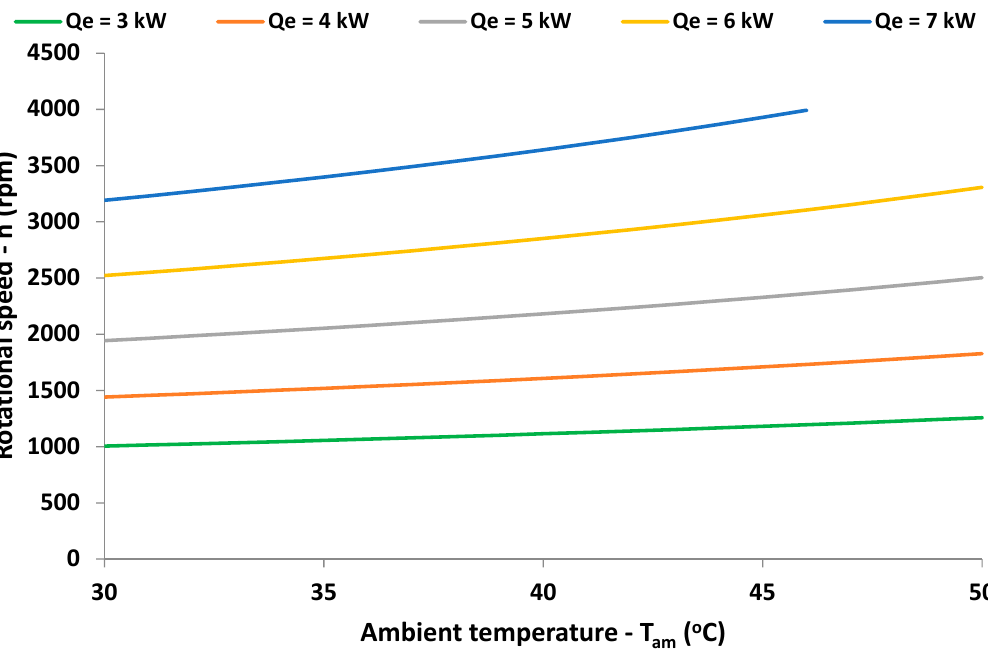
Figure 16. Cooling capacity for different ambient temperatures and COP ( T ind = 25 °C and 1000 rpm < n < 4000 rpm).